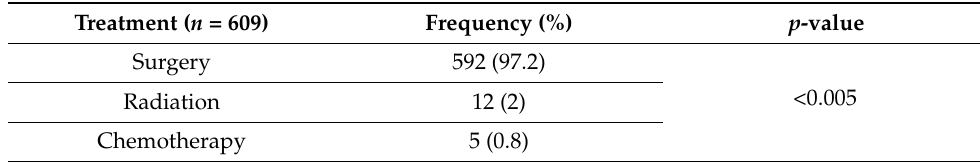
Table 6. Treatment characteristics of 609 patients with parathyroid cancer from the Surveillance, Epidemiology, and End Results (SEER) database, 1975–2016.